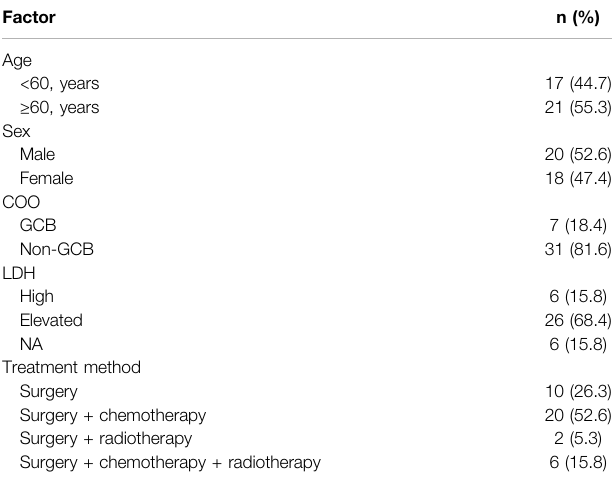
TABLE 1 | Clinicopathological information of the 38 PCNSL